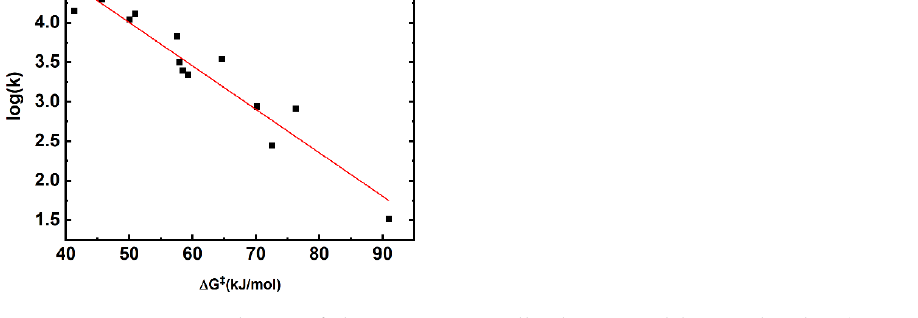
Figure 2. Linear correlation of the computationally determined barrier heights (B2PLYP-D3/6-311+(2df,2p)) versus log( k ).